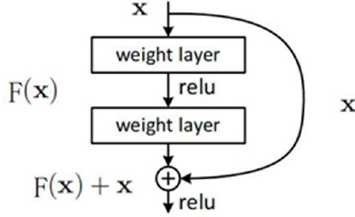
Figure 1. Residual